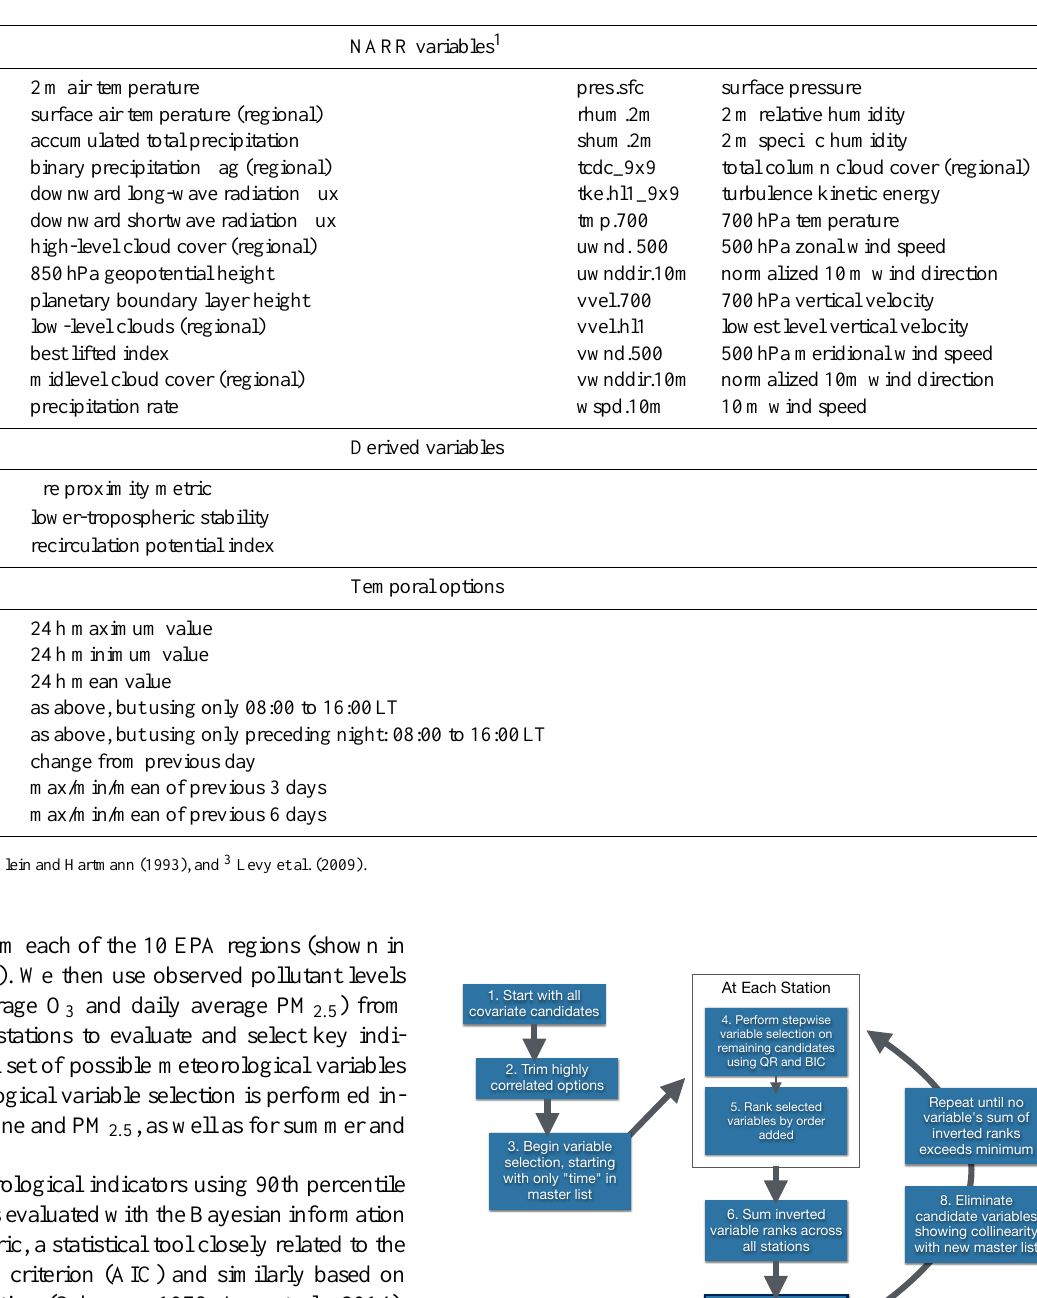
Table 1. Meteorological fields used in variable selection procedure. Each NARR field shown was included using nine different possible daily values (24h max/min/mean, 8h daytime max/min/mean, previous 8h nighttime max/min/mean), as well as longer term (3- and 6-day) aggregates and 1-day deltas of those daily values. Variables marked “9x9” represent regional means, and were generated by averaging the 9 × 9 square of NARR grid cells centered around each station location (roughly 290km per side).